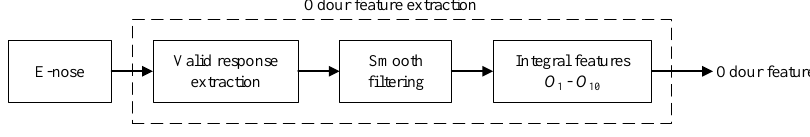
Figure 9. Odor features extraction method.